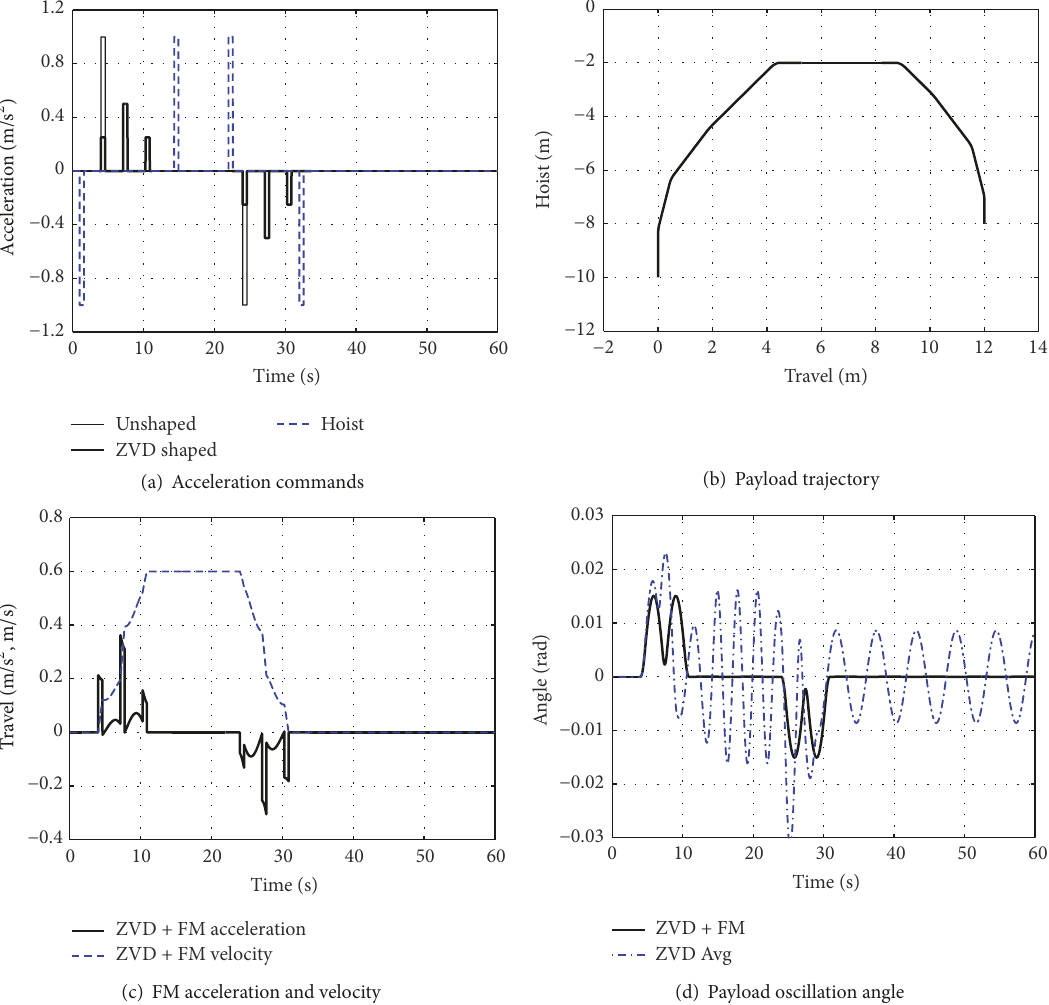
Figure 6: Simultaneous travel and hoisting maneuver using FM shaped command with primary ZVD input